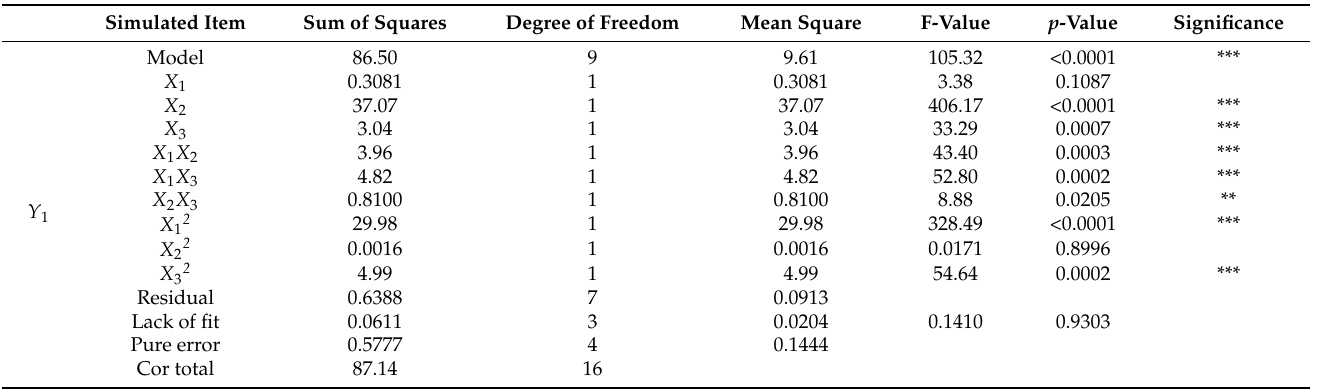
Table 5. Analysis of variance of regression